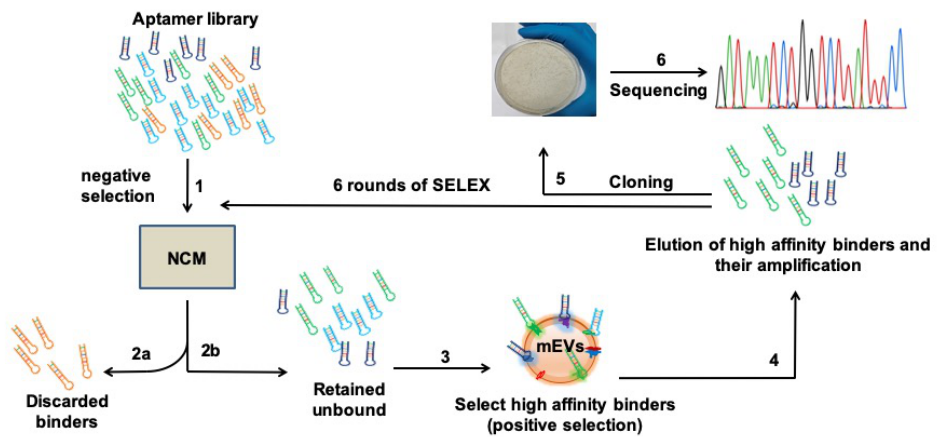
Figure 1. Schematic representation of Systematic Evolution of Ligands by EXponential enrichment (SELEX) process employed for shortlisting high-affinity aptamers specific to mycobacterial EVs. Aptamer library was first (step 1) negatively selected on a blank nitrocellulose membrane (NCM). The bound aptamers (step 2a) were discarded, and unbound aptamers (step 2b) were taken forward to screen for high-affinity binders to Mycobacterium smegmatis (Msm) EVs (step 3). The bound high- affinity binders were then eluted and amplified (step 4). Steps 1 to 4 were followed for an additional six rounds of SELEX to shortlist the best binders to mEVs. Finally, the shortlisted binders were cloned (step 5) and sequenced (step 6).